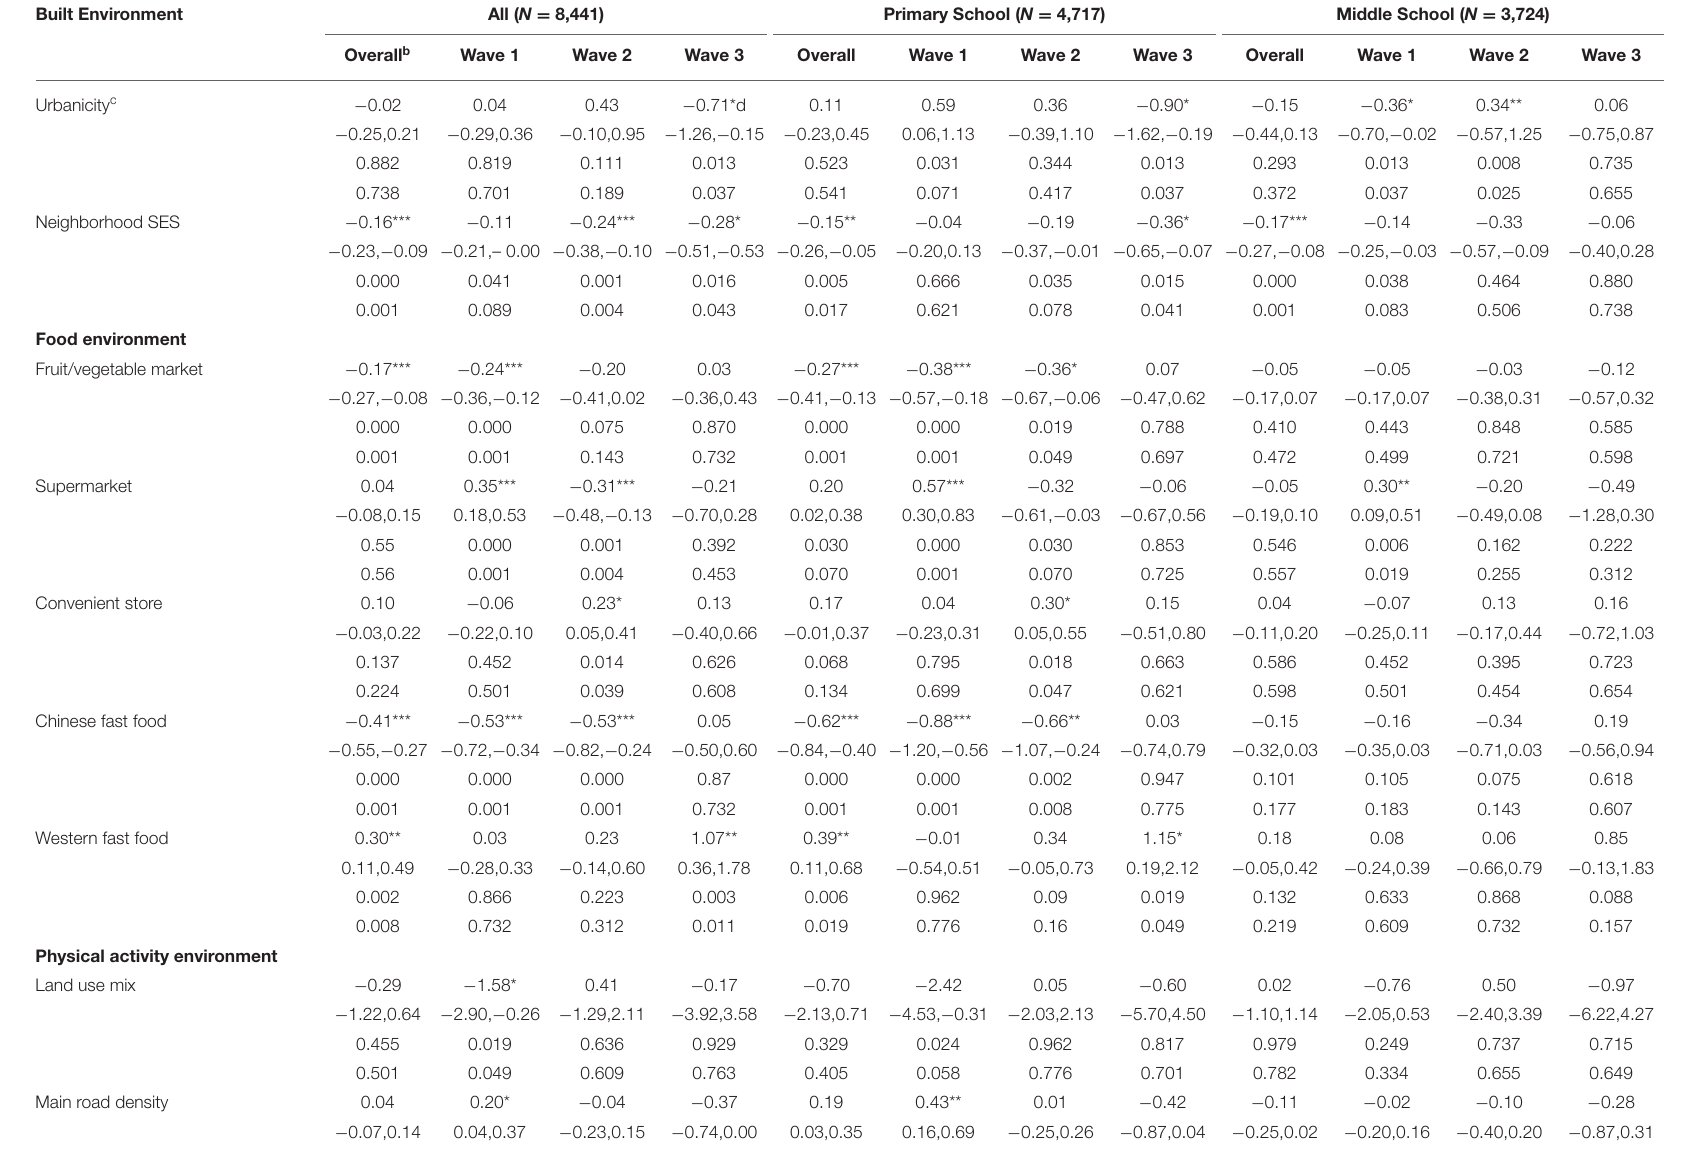
TABLE 2 | Associations of neighborhood built environments and child body mass index (BMI) 2011-2016 a